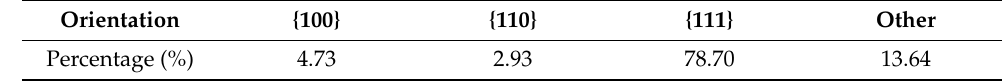
Figure 2. Macro- and microtexture of as-received IF steel, ( a ) ϕ 2 = 45 ◦ ODF section from the X-ray diffraction; ( b ) IPF from EBSD. Table 2. The percentage of low-index